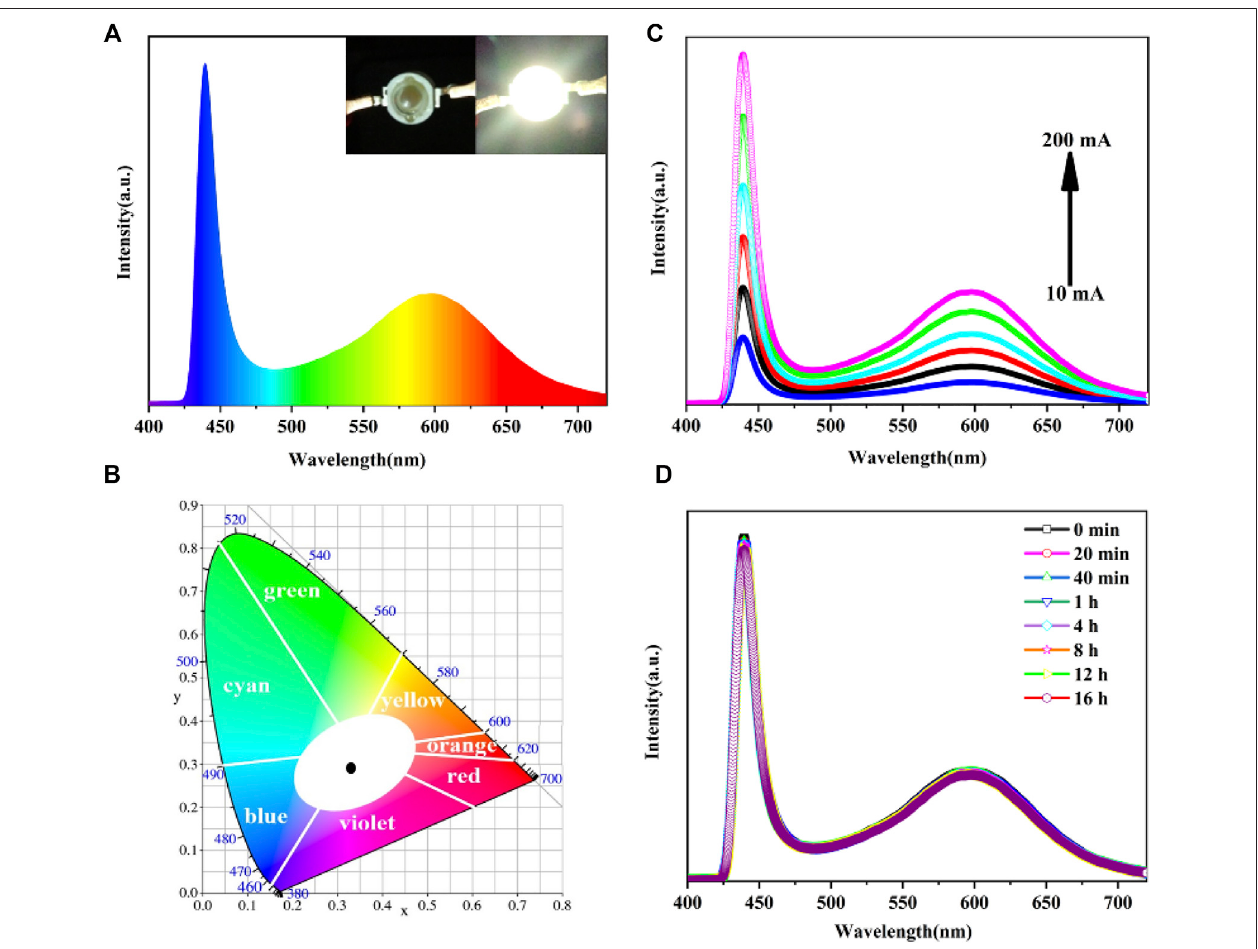
FIGURE 6 | (A) White emission spectrum under a 20 mA drive current; (B) CIE chromaticity coordinates of the device; (C) Relationship between the WLED emission spectrum and the working current; (D) PL spectra of WLED measured at different times (Wu et al., 2020).